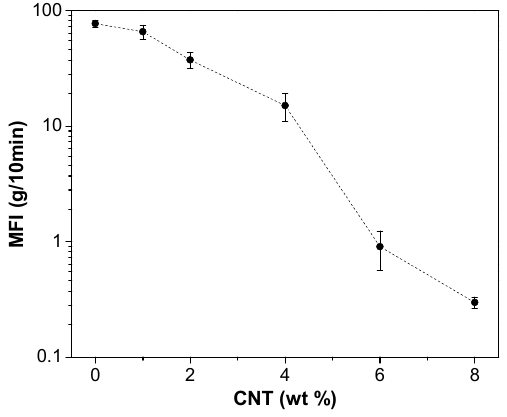
Figure 2. Melt flow index of ABS nanocomposites as a function of CNT fraction at 250 °C with applied load 10 kg.